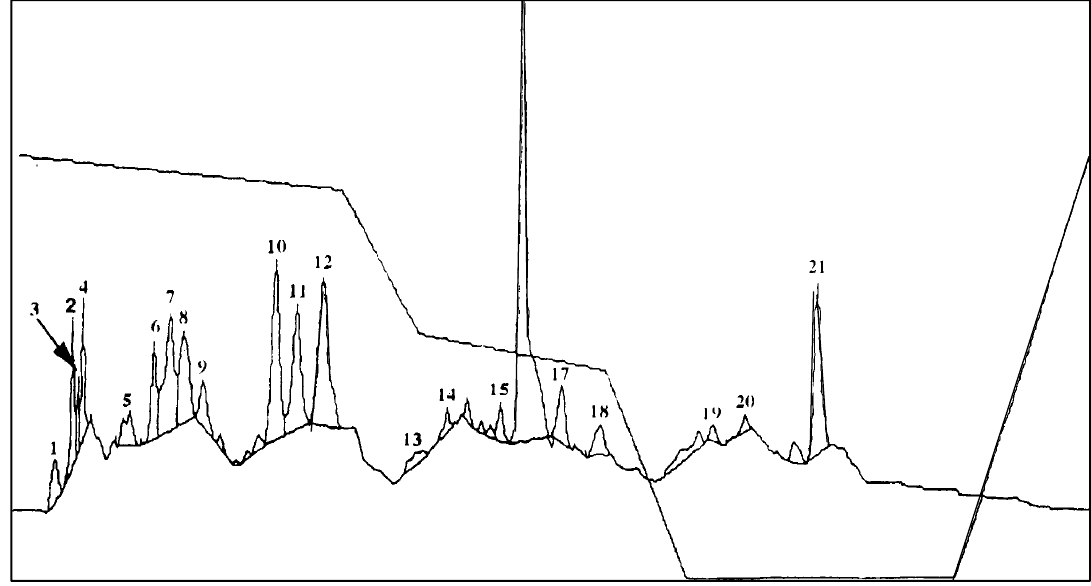
Figure 2. Chromatogram of alfalfa root parts–derived saponins. Peak 10: 3-Glc, 28 AraRhaXyl medicagenic acid (MA); peak 12: 3-Glc, 28-Glc MA; peak 16: 3-GlcA, 28 AraRhaXyl MA; peak 18: soyasaponin I; and peak 21: 3Glc MA.